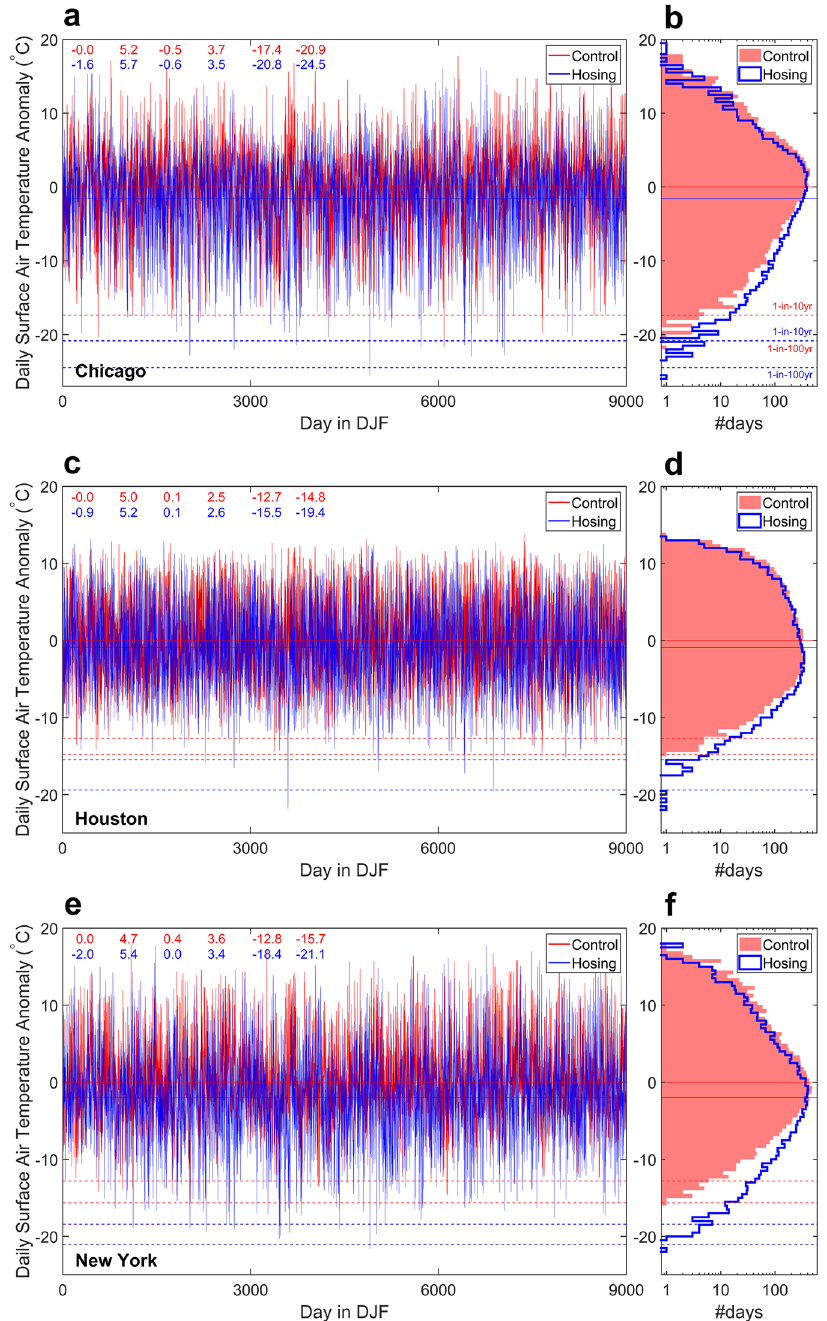
Fig. 4 Response of DJF daily temperature anomalies ( Δ T s ) at three cities of the U.S. in the hosing experiment. a , b Chicago; c , d Houston; e , f New York. a , c , e Time series for 100 years or 9000 DJF days. In both curves, the daily climatology from the control has been removed and the mean cooling remains in the curve of the hosing run. b , d , f The histograms. The y -axis and x -axis are the temperature anomaly and the number of days, respectively. Note the x -axis uses a logarithmic scale. The solid horizontal lines show the long-term mean. The dashed horizontal lines denote the return levels for the 1-in-10-year and 1-in-100-year cold events. The statistics of the time series are listed at the upper left corner (from left to right: long-term mean, standard deviation, skewness, kurtosis, c Δ T 10 s and c Δ T 100 ). These statistics are calculated based on years 1 – 100 of the control run and years 21 – 100 of the hosing run. The 90% s 10 100 con fi dence bounds of c Δ T and c Δ T quanti fi ed by the bootstrapping can be found in Supplementary Fig. s s